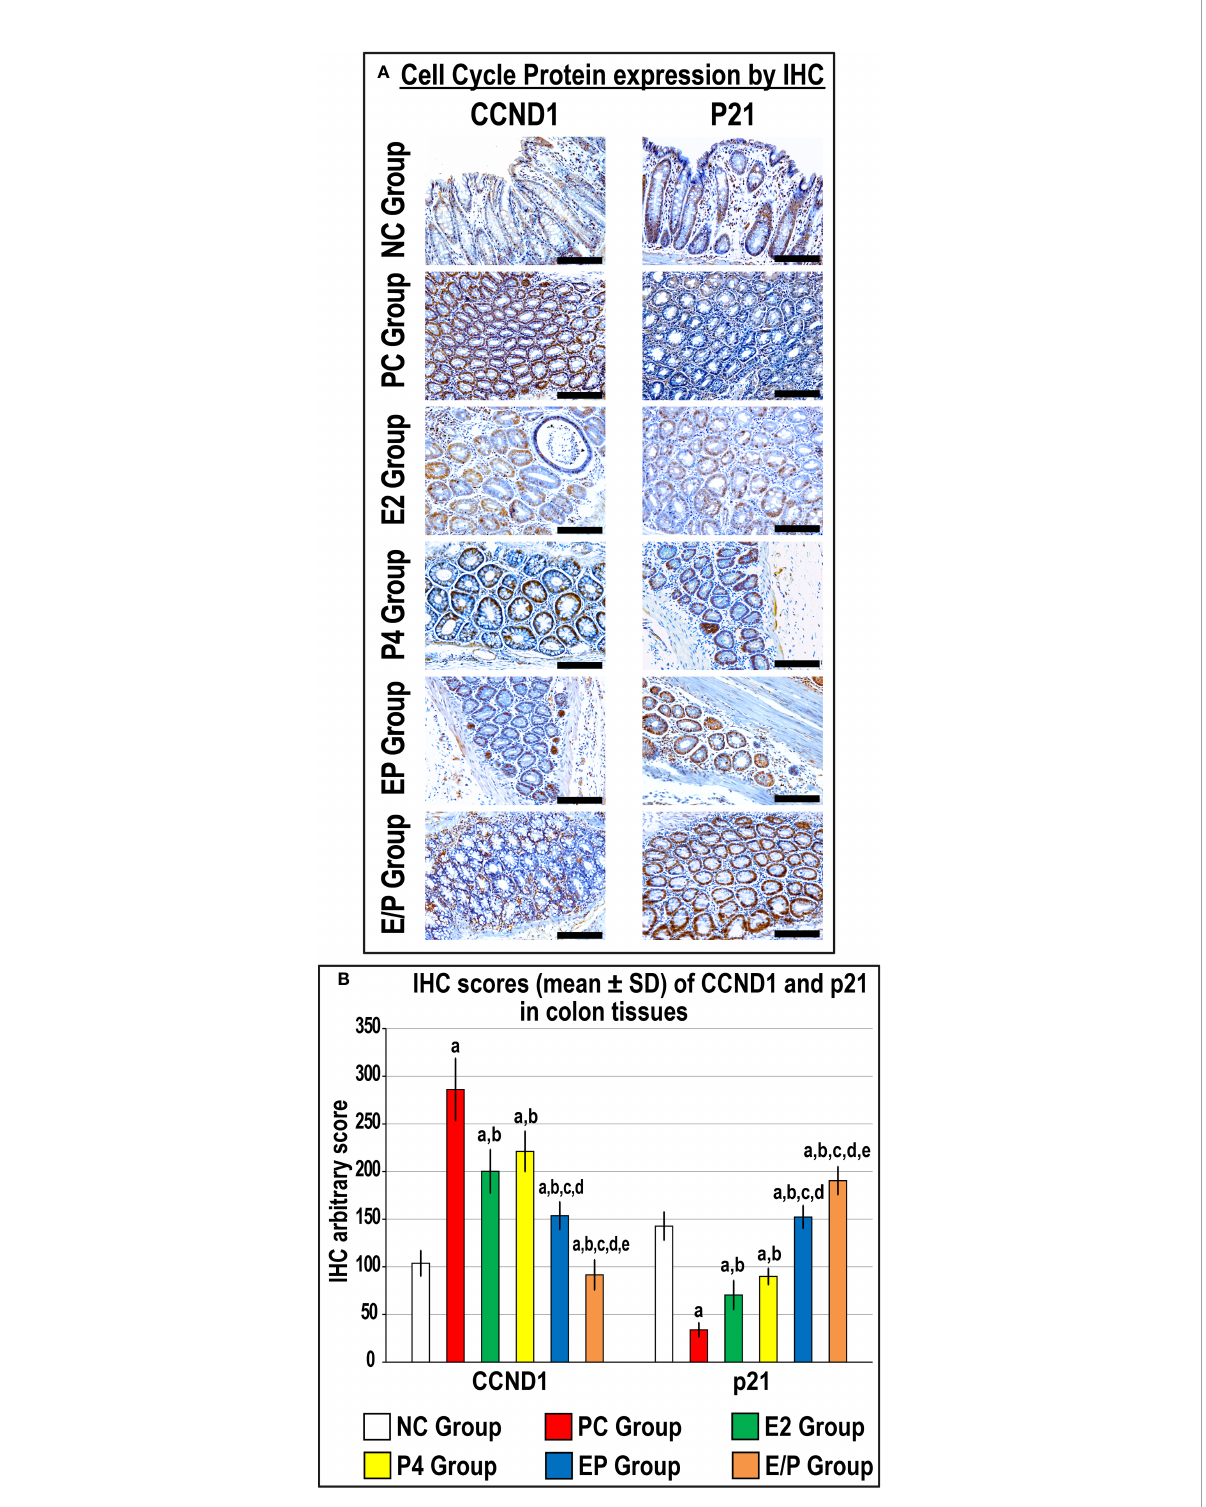
FIGURE 2 (A) Localisation of CCND1 and p21 proteins by immunohistochemistry (IHC) in male mouse colonic tissues from the different groups (20× objective; Scale bar = 15 m m). Moreover, (B) IHC arbitrary scores from the different groups are shown as graph bars (mean ± SD; a P< 0.05 compared with the NC group; b P< 0.05 compared with the PC group; c P< 0.05 compared with E2 monotherapy; d P< 0.05 compared with P4 monotherapy and e P< 0.05 compared with EP concurrent dual therapy